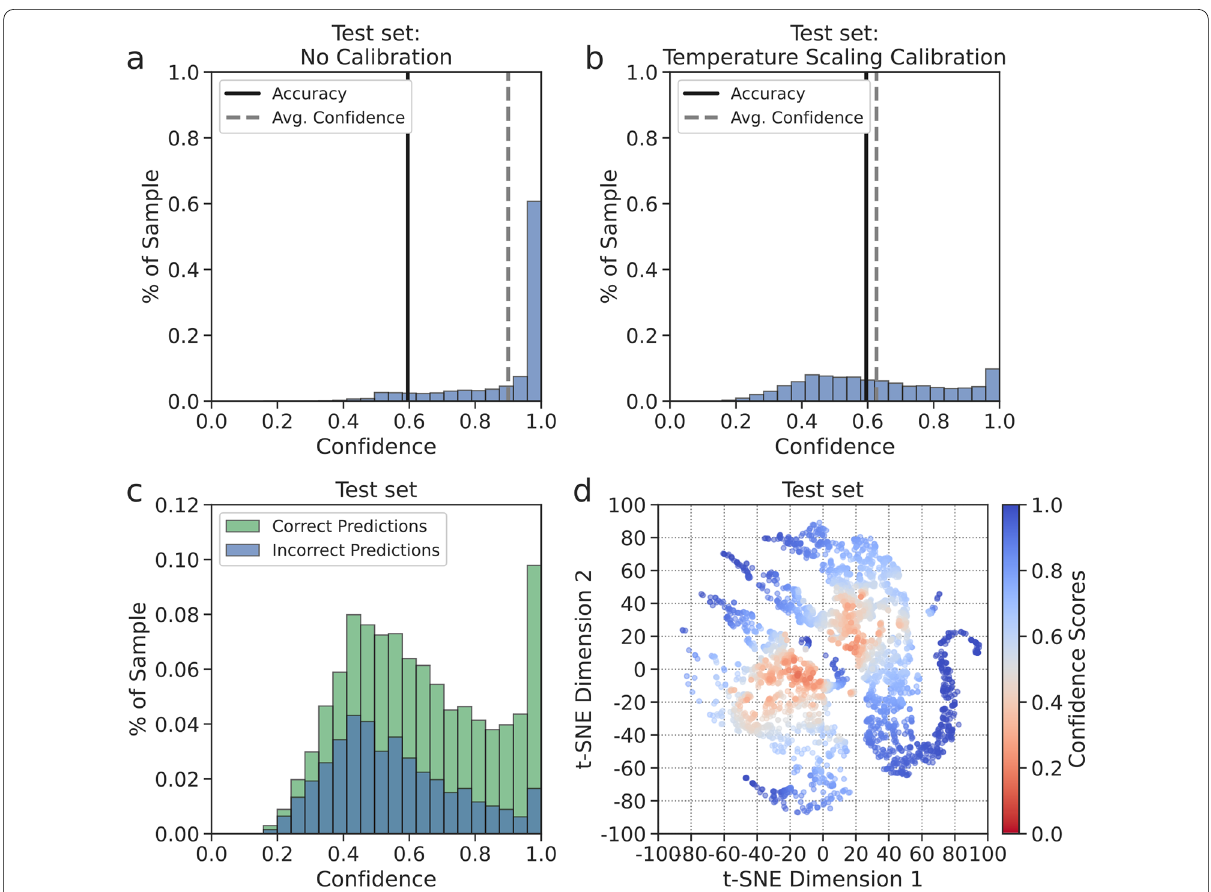
Fig. 5 Confidence histograms comparing the average confidence to expected accuracy ( a , b ). Stacked confidence histogram for correct and incorrect predictions ( c ). Confidence scores were depicted on a t-SNE scatter plot ( d